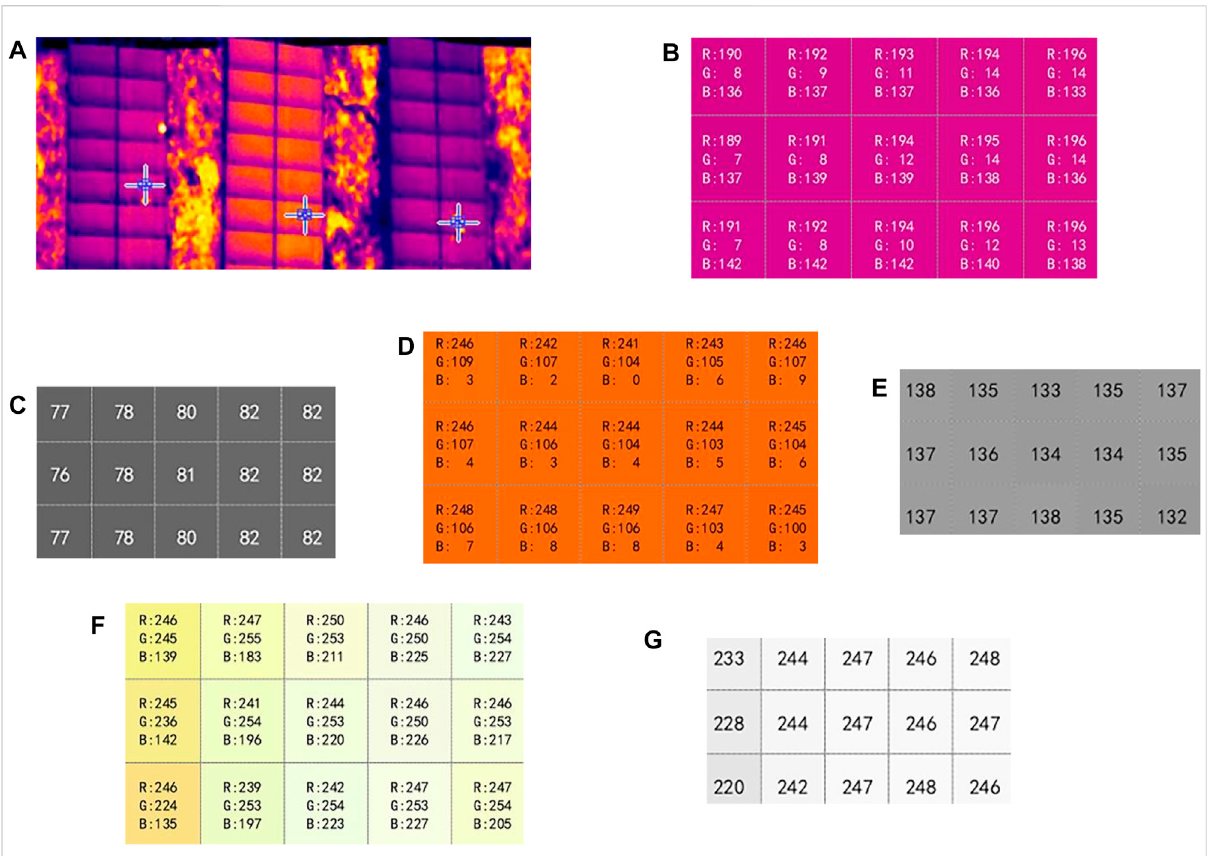
FIGURE 8 RGBandgreyvaluesoftargetareas: (A) Testareasfromlefttoright:normalarea,dustcoveredarea,plantsshelterarea. (B) RGBvaluesofnormal area. (C) Grey values of normal area. (D) RGB values of dust covered area. (E) Grey values of dust covered area. (F) RGB values of the area shaded by plants. (G) Grey values of the area shaded by